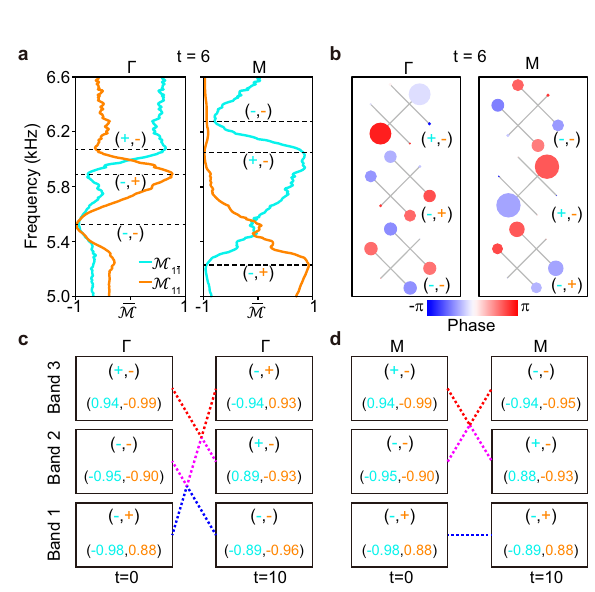
Fig. 4 | Experimental characterization of mirror eigenvalues and band inver- sions. a Expectation value spectra of the mirror operators M 1 (cid:1) 1 and M 11 extracted for the HSP states at t =6. ± label the mirror eigenvalues of the HSP states at predicted eigen-frequencies (dashed lines). b Mapped fi eld distributions for the HSP states, in which the size and color of the circles characterize the sound intensities and phases of the detecting points, respectively. c , d Band inversions manifestedbythemirrorexpectationvalues(numbers)measuredfortheinitialand fi nal moments. Stable nodes can be concluded at Γ for the gap-II and at M for the gap-I, from the data of t =10.